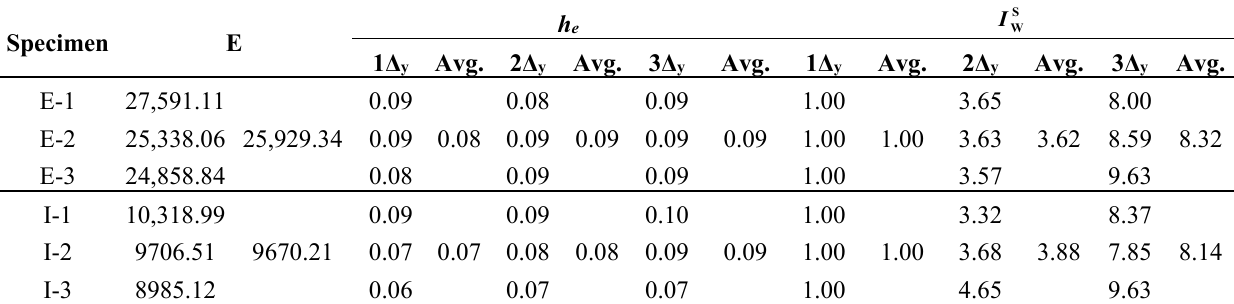
Table 2. Viscous damping coefficient and work ratio